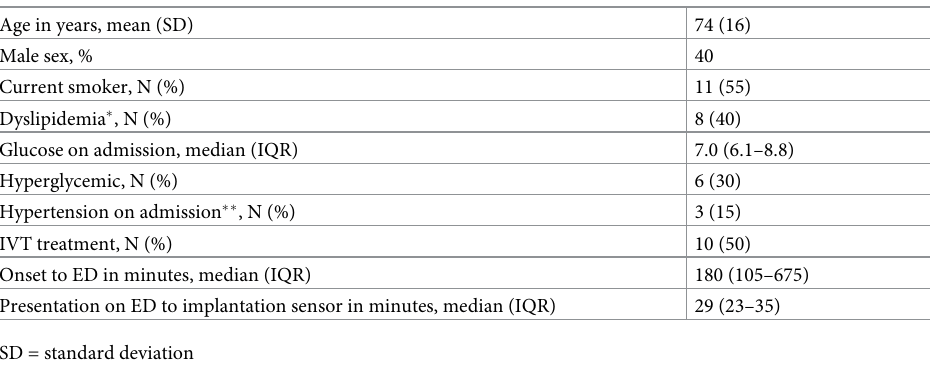
Table 1. Patient characteristics (N =